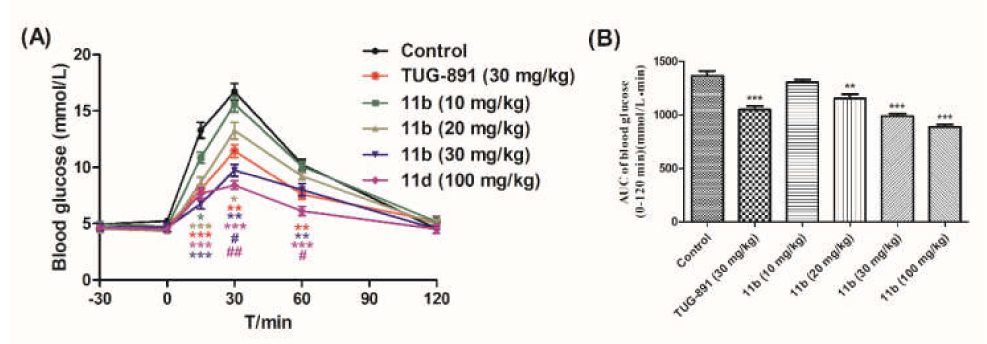
Figure 3. Effects of compound 11b and TUG-891 on plasma glucose levels during the oral glucose